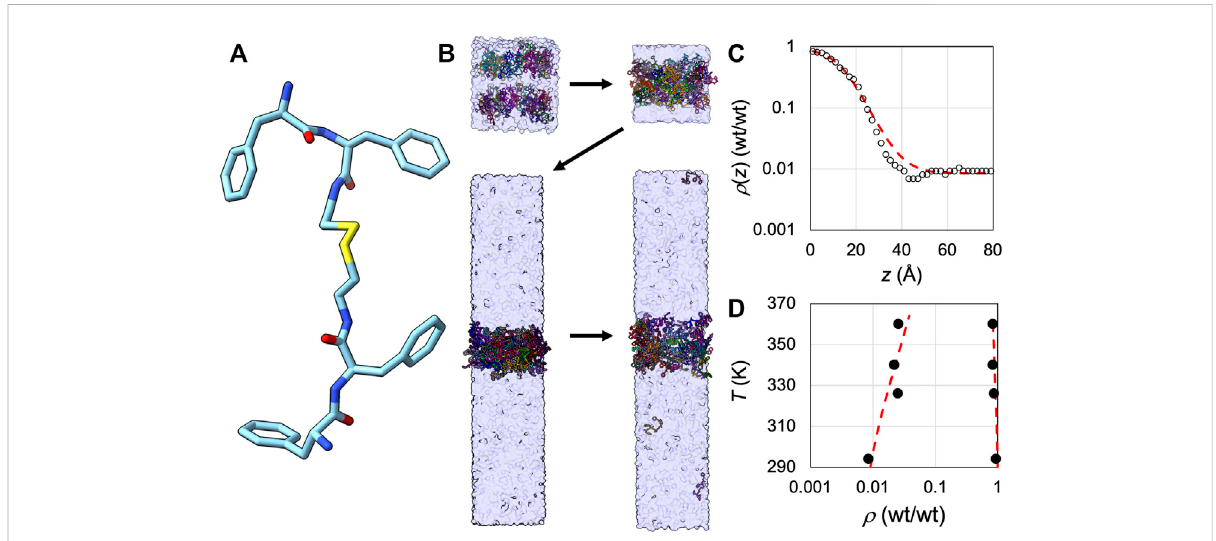
FIGURE 6 Application of SpiDec to a phase-separating peptide. (A) Structure of FFssFF. (B) The SpiDec simulation procedure. First, a random, loose con fi guration condensed into a single slab. Then the slab was solvated into an elongated box and the two phases reached equilibrium. The fourth snapshot shown was taken at 1.065 µs of a 2-µs simulation at 294 K. (C) Concentration pro fi le (circles) at 294 K and fi t to eq [6] (red curve). Concentrationswerecalculatedbycountingcopynumbersin2-Åslicesalongthe z direction;thelocationofeachcopywasrepresentedbythe midpoint of thecentral disul fi debond. The conversion of concentrations to wt/wt used amolecularweightof 741.5 Da for the peptide and a density of 1 kg/L for water. (D) Dilute- and dense-phase concentrations at four temperatures, from 294 K to 360 K. The red curve shows a binodal to guide the